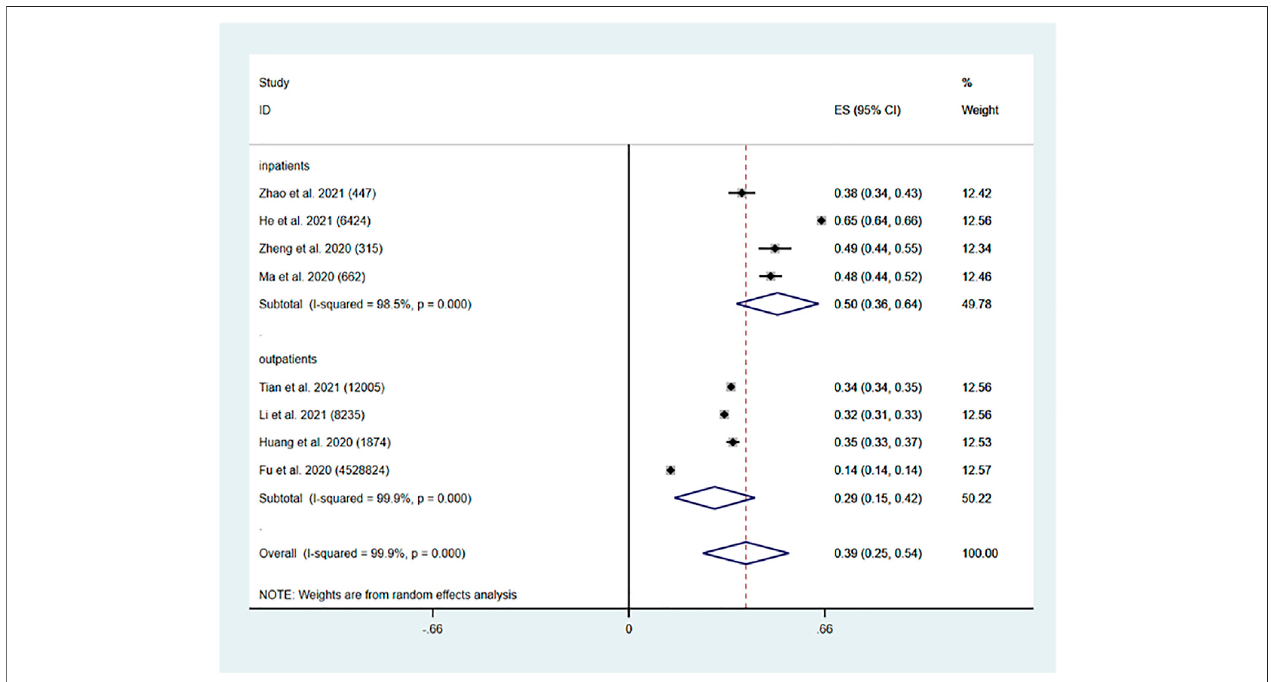
FIGURE 3 | Prevalence of PIM use in the Chinese elderly population.